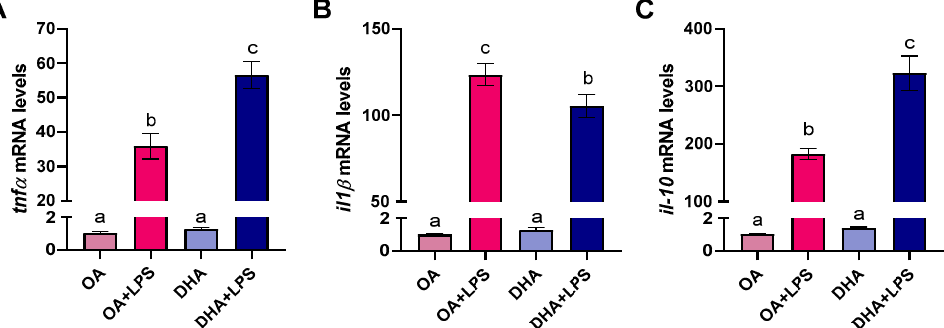
Figure 8. Transcript levels of tumor necrosis factor ( tnf- α ) ( A ) interleukin 1 β ( il-1 β ) ( B ), and interleukin 10 ( il-10 ) ( C ) in mature adipocytes incubated for 6 days with 100 µ M oleic acid (OA) or 100 µ M docosahexaenoic acid (DHA) and thereafter exposed to lipopolysaccharide (LPS) for 20 h (OA + LPS and DHA + LPS, respectively). Samples ( n = 8 for OA and DHA groups and n = 6 for OA + LPS and DHA + LPS) were analyzed with real-time qPCR. Data are presented as fold change ± SEM using ef1 α as a reference gene and the OA group was set to one (delta-delta method). Di ff erent letters indicate significant di ff erences between treatments ( p < 0.05, ANOVA followed by Tukey’s post hoc test). Changes in the transcript abundance of mitochondrial fission 1 ( fis-1 ) and mitofusin 1 ( mfn-1 ), two genes involved in mitochondrial fission and fusion, respectively, together with changes in tumor protein P53 binding protein 2 ( p53bp2 ) were assessed (Figure 9). The transcript levels of these genes were not modified by the FA the cells were incubated with (i.e., OA group and DHA group).